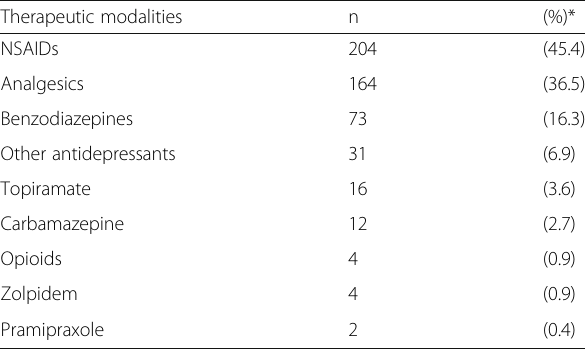
Table 4 Non-pharmacological therapeutic modalities used by patients with